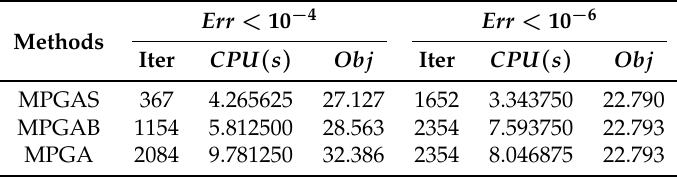
Table 2. Results for Example 2 with x 0 = 2 ∗ rand ( 200,1 )